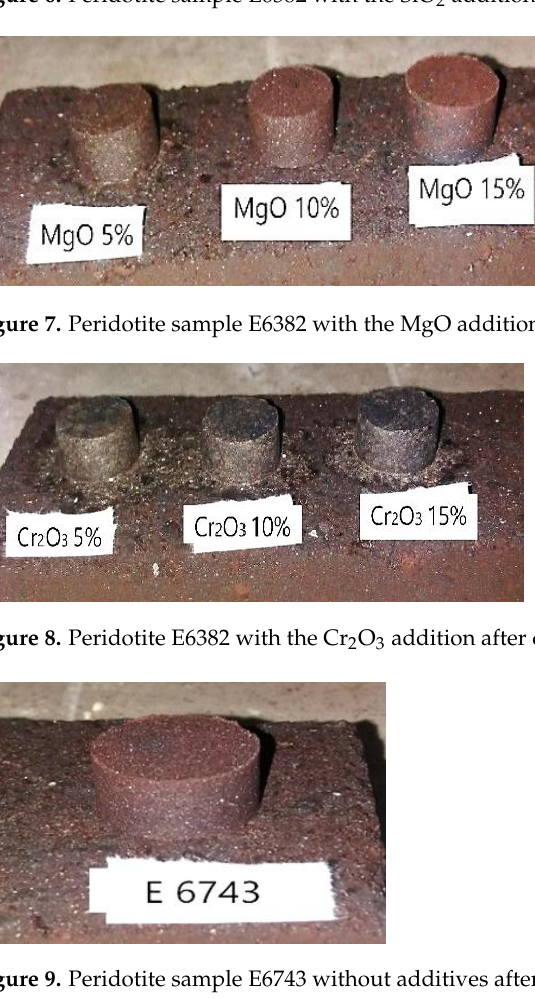
Figure 9. Peridotite sample E6743 without additives after calcination. Figure 10. Peridotite sample E6743 with the CaO addition after calcination. Figure 11. Peridotite sample E6743 with the Al 2 O 3 addition after calcination.